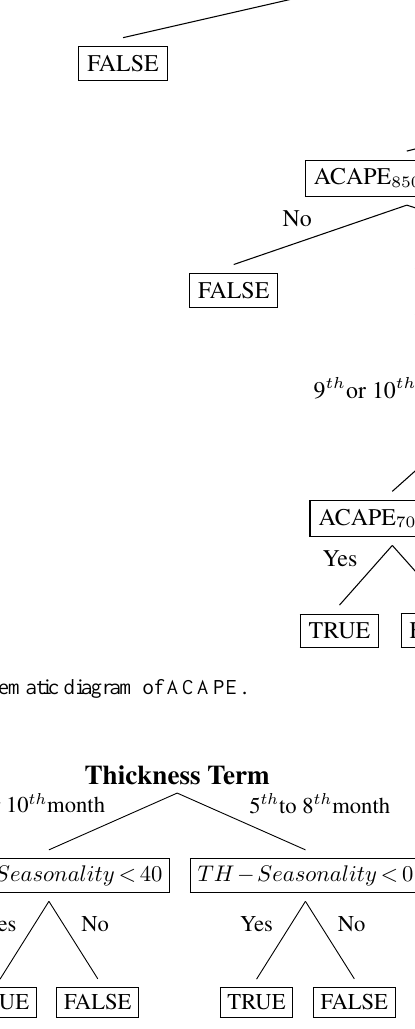
Fig. 2. Schematic diagram of ACAPE